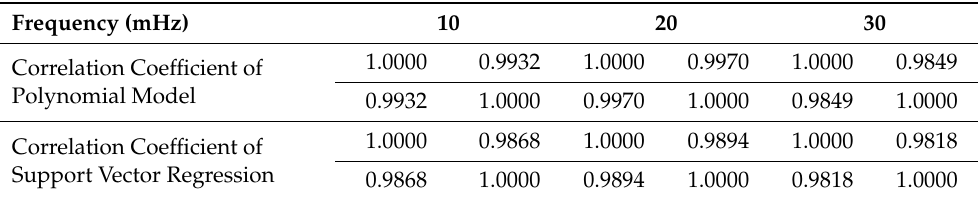
Table 7. Correlation Coefficient between observed and predicted stiffness at different frequencies.